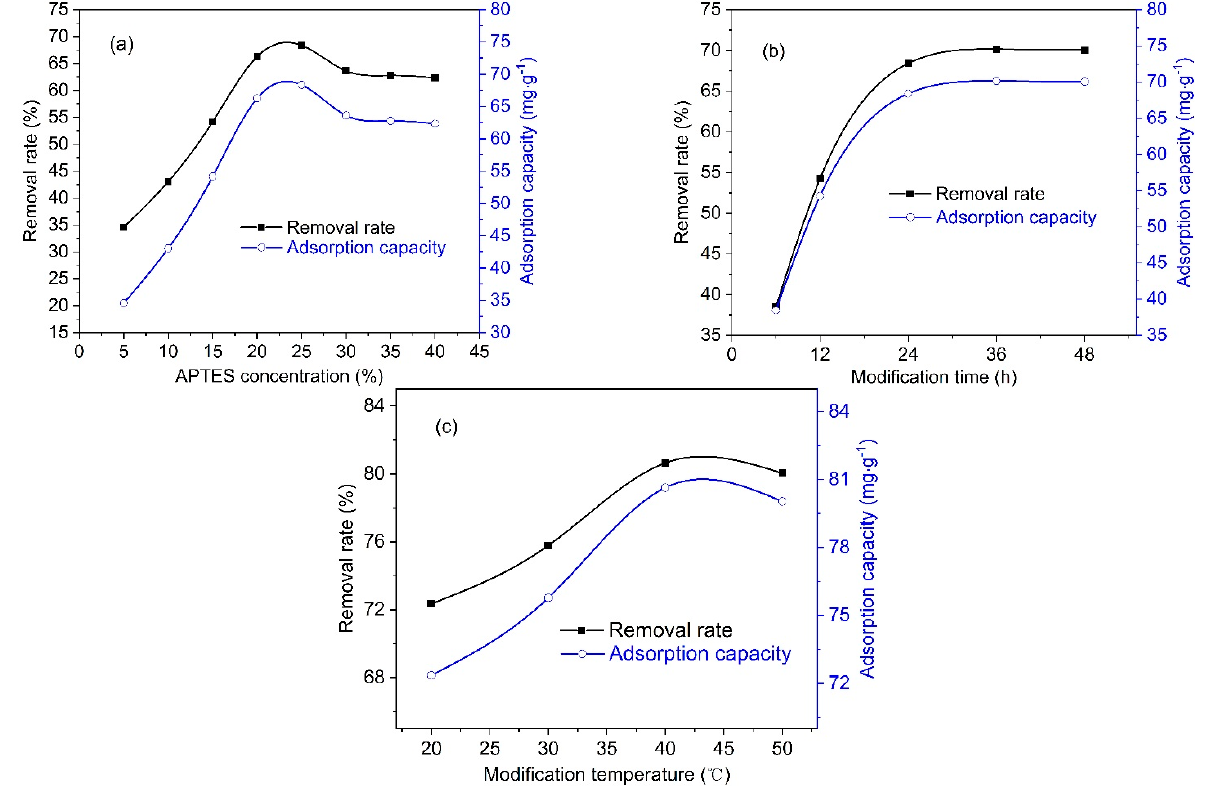
Figure 9. The effect of APTES concentration ( a ), modification time ( b ) and modification temperature ( c ) on the adsorption of lead ions on the modified slag.